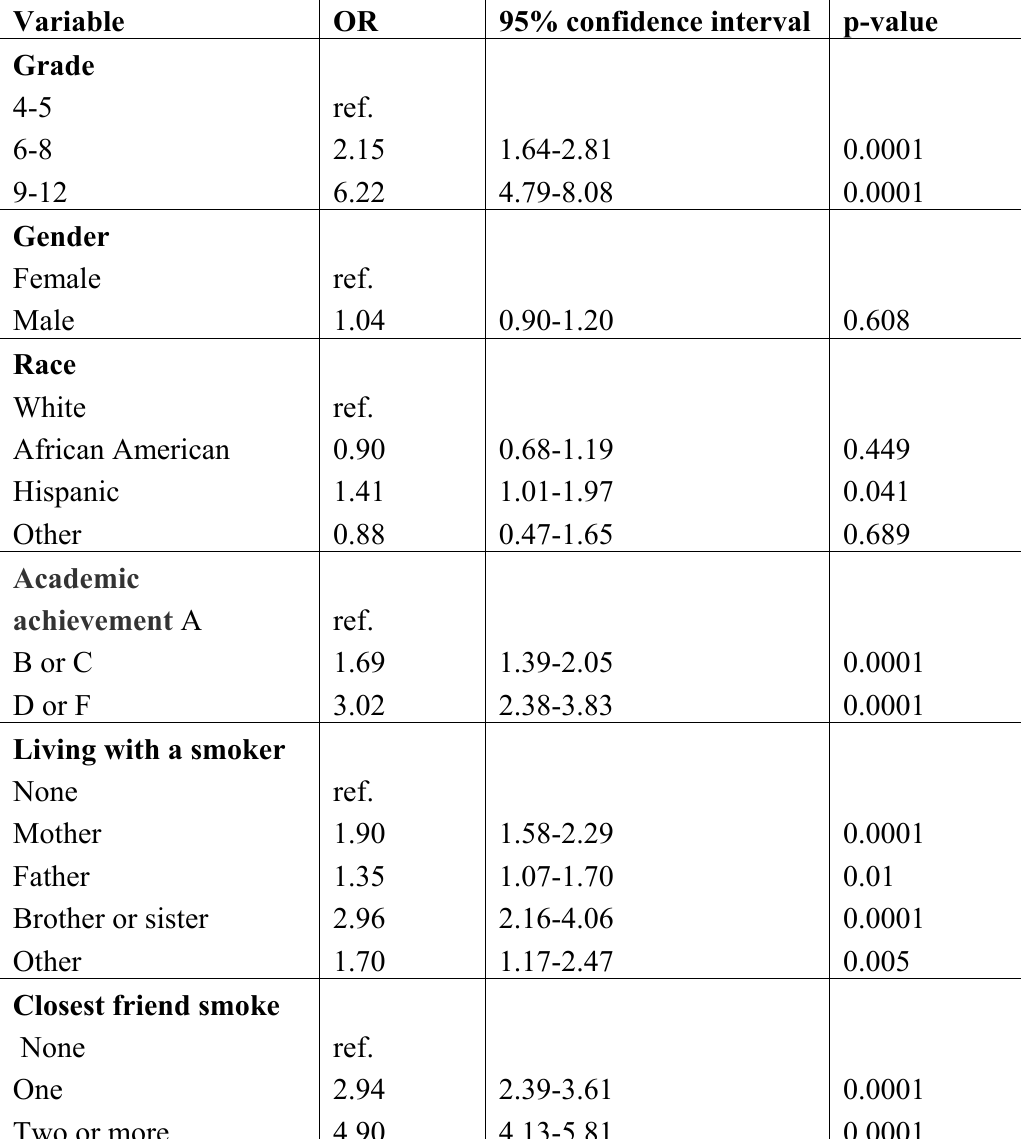
Table 3. Correlates of smoking initiation among adolescents in Northwest